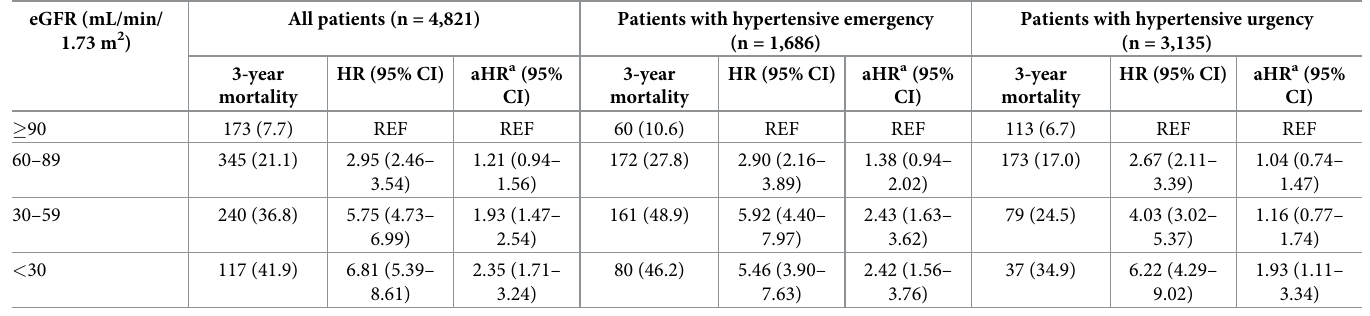
Data are presented as n (%). HR, hazard ratio; aHR, adjusted hazard ratio; CI, confidence interval; eGFR, estimated glomerular filtration rate. a Adjusted for age, sex, systolic blood pressure, diastolic blood pressure, proteinuria, cardiomegaly on chest radiography, left ventricular hypertrophy, myocardial ischemia, and atrial fibrillation on electrocardiography, and medical history of hypertension, diabetes mellitus, dyslipidemia, ischemic stroke, hemorrhagic stroke, coronary artery disease, heart failure, and peripheral artery